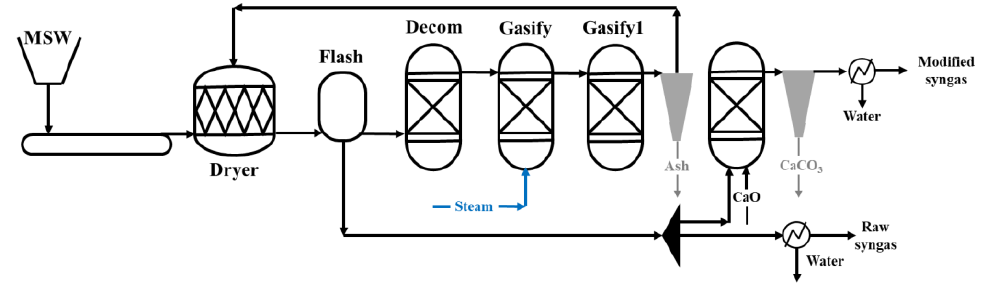
Figure 4. Schematic diagram of the simulation model.